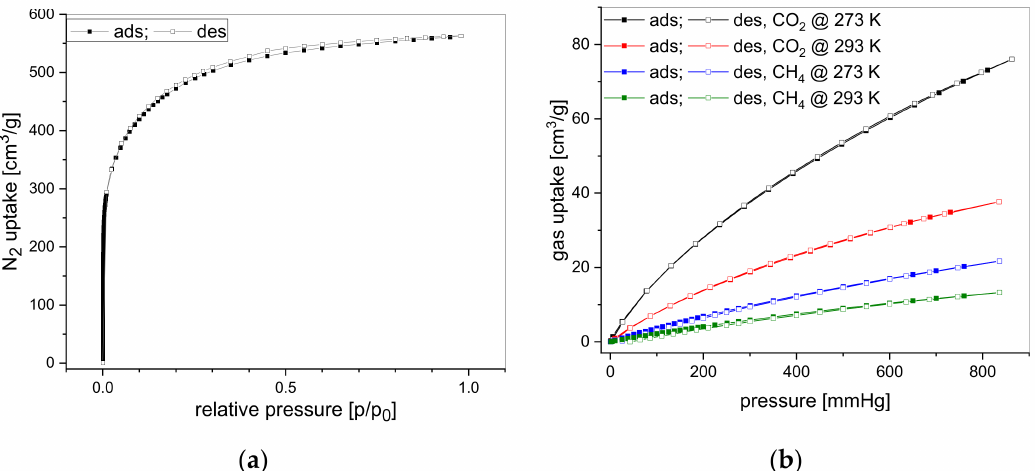
Figure 3. Nitrogen adsorption–desorption isotherms at 77 K ( a ), as well as carbon dioxide and methane uptake at 1 bar ( b ) for triazine framework CTF-hex6 , are shown exemplarily (closed symbols for adsorption and open symbols for desorption). The other isotherms are shown in Figures S5 and S7 in the Supporting